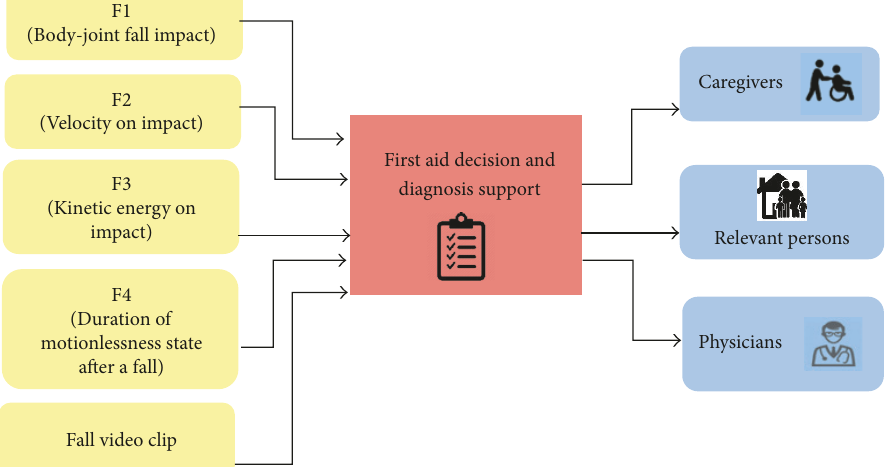
Figure 8: The modular structure for supporting decisions in first aid and diagnosis by caregivers and physicians.